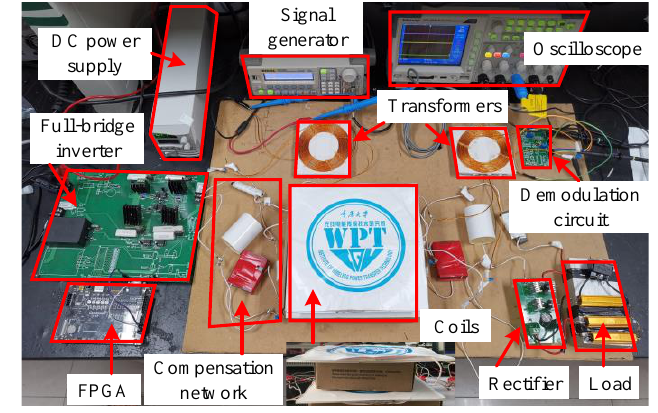
Figure 13. Experimental setup.